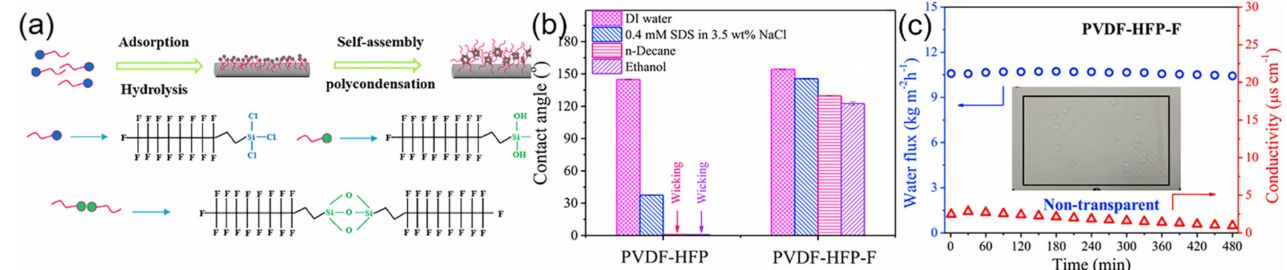
Figure 7. ( a ) Schematic illustration of vapor deposition fluorination; ( b ) Contact angles of DI water and other liquids on PVDF-HFP and PVDF-HFP-F membranes; ( c ) Conductivity and water flux verses time of the PVDF-HFP-F membrane in DCMD. Reprinted with permission from Ref. [120]. 2020,